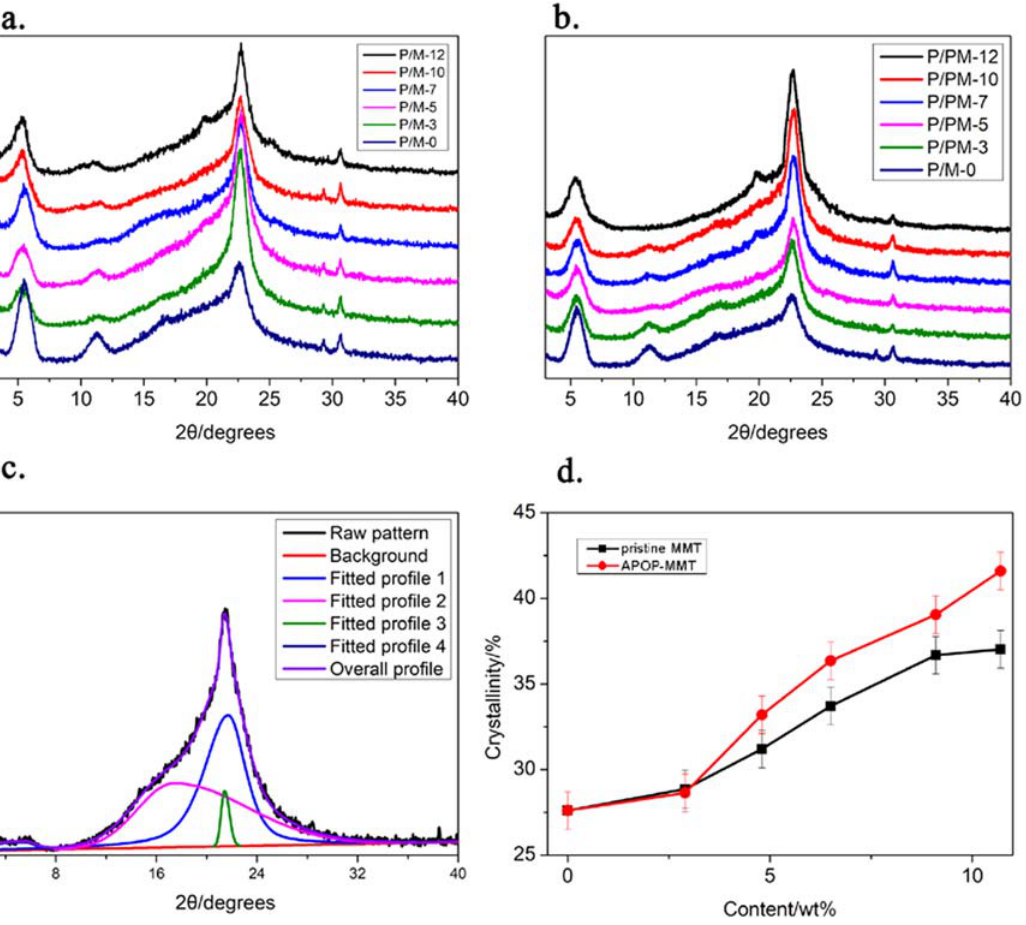
Figure 9: XRD spectra of MMMs: ( a ) pristine MMT/PEBAX ® 1074, ( b ) APOP - MMT/PEBAX ® 1074, ( c ) peak fi tting results of quenched pure PEBAX ® 1074 membrane, ( d ) crystallinities of the